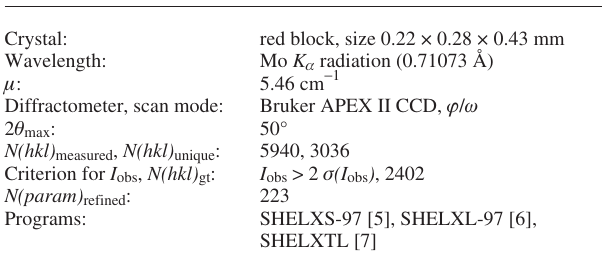
Table 1. Data collection and handling.